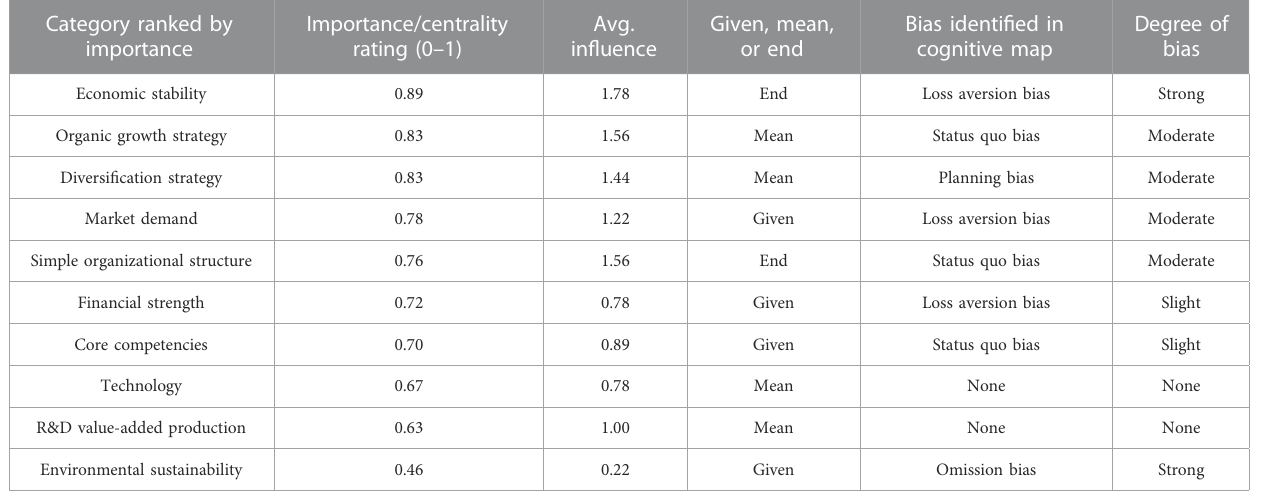
TABLE 2 Example of bias identi fi ed through the cognitive map of Company A. Category ranked by